Question: Write a descriptive caption for this figure.
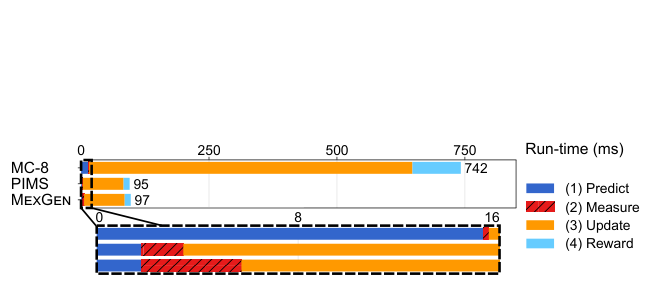
Answer: Run-time analysis results for planners with the different measurement prediction methods running on the processor used on our aerial robot (total time is divided into the planning stages in § IV). Our MEXGEN method achieves 7.6× speed-up compared to MC-8 and significantly better task performance than PIM (see Table I and II). Notably, the relatively small measure time of MC-8 is because PIM and MEXGEN measure times include the cost of the expectation. The results demonstrate the asymmetric computational cost of the measurement function (Measure time) and the belief state update (Update time) we leverage in our approximation.